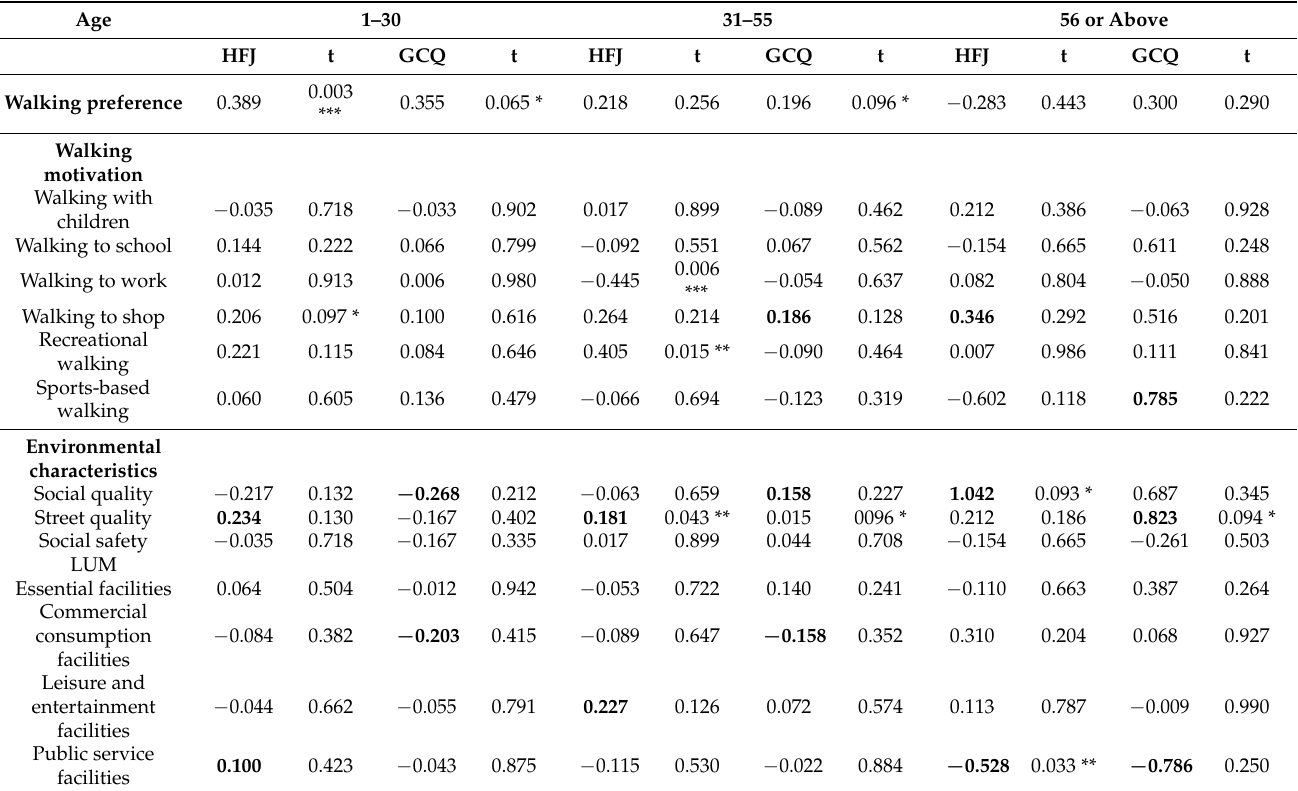
The data of pedestrian walking experience of different age groups show that (Table 7): Table 7. Correlation analysis of daily walking time and multiple factors of pedestrians of different ages on two